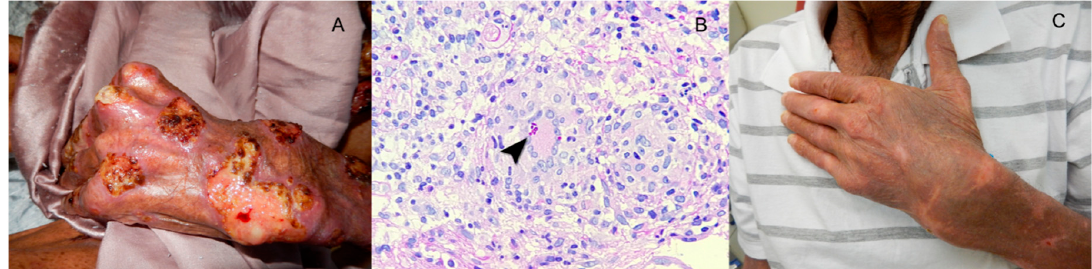
Figure 2 . Ulcerated lesions in the hand and fist of a patient with human immunodeficiency virus (HIV) infection ad cutaneous disseminated sporotrichosis and immune reconstitution syndrome ( A ). A skin biopsy ( B ) depicted an exudative and granulomatous infiltrate with cigar shape and round yeast cells (arrow head), imbibed in multinucleate giant cells of the Langerhans type. Periodic Acid-Schiff stain × 400. The patient responded well to long course of continuous itraconazole intercalated with short courses of cotrimoxazole for secondary bacterial infection and prednisone for immune reconstitution inflammatory syndrome (IRIS) control ( C ).